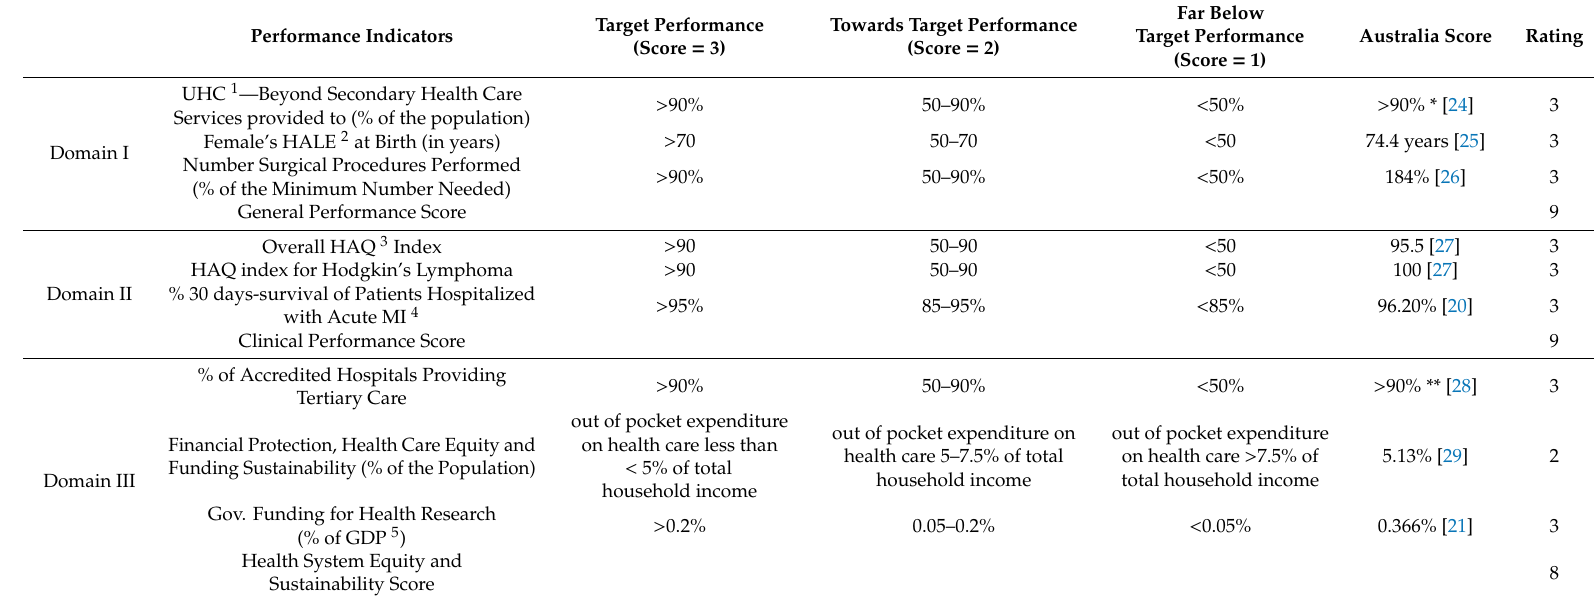
Table 1. Ranking the Australian Health